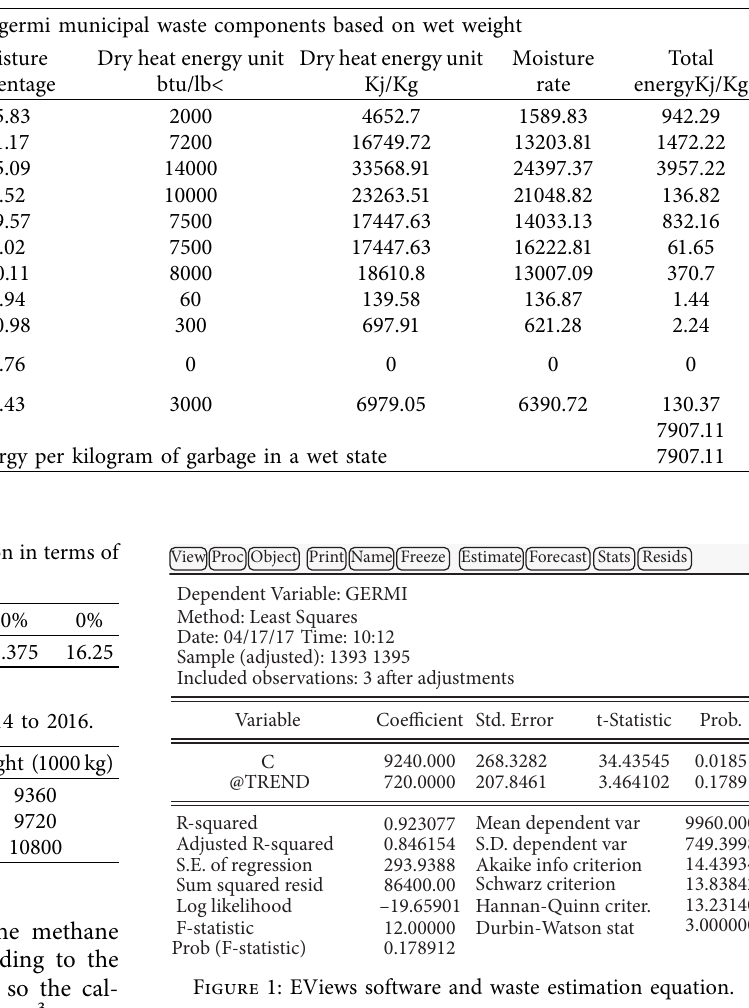
Table 2: percentage of weighted arithmetic mean of waste components and thermal value per kilogram of garbage in Germi [https:// pasmand.ardabilcity.ir].